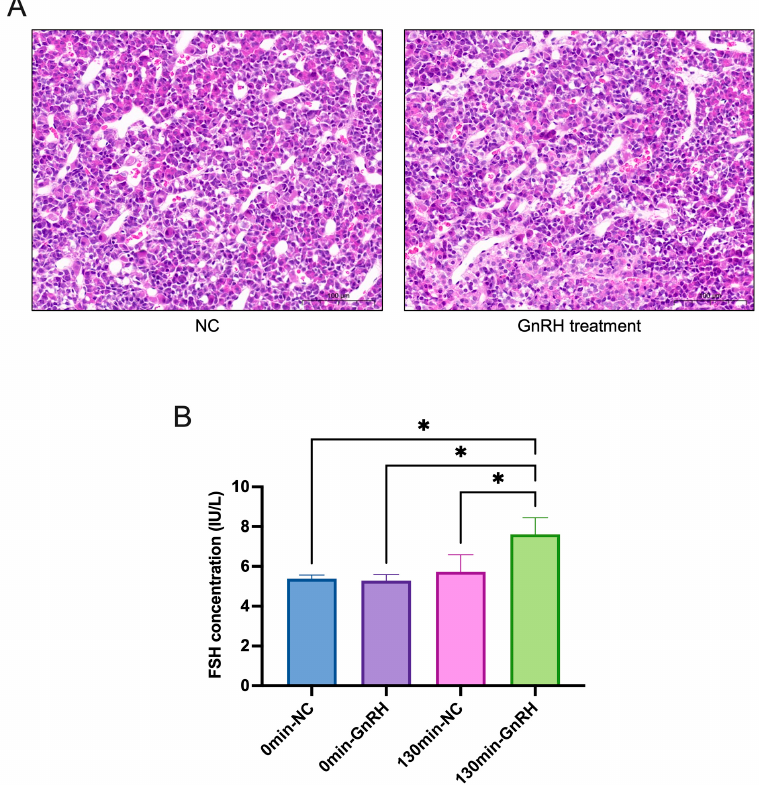
Figure 1. GnRH treatment upregulates FSH secretion. ( A ) HE staining of the rat adenohypophysis after GnRH treatment. ( B ) ELISA to detect the changes in FSH secretion levels in rats after GnRH treatment (0 min-NC/GnRH: the blood collected before injection; 130 min-NC/GnRH group: the blood collected 10 min after the second injection.). * p < 0.05.